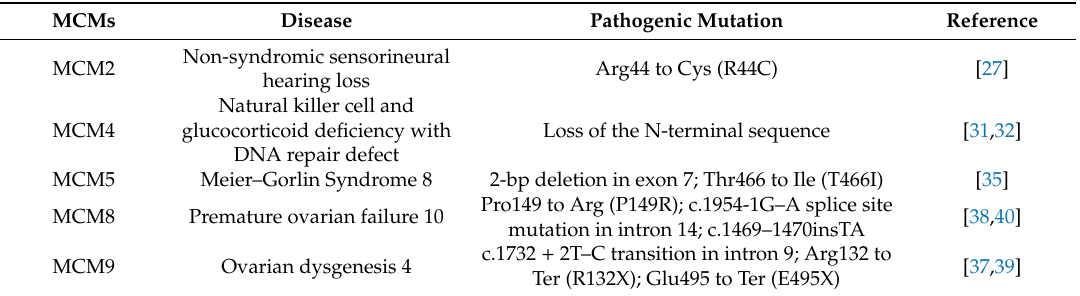
Table 1. Human diseases associated with mini-chromosome maintenance (MCM) variants.